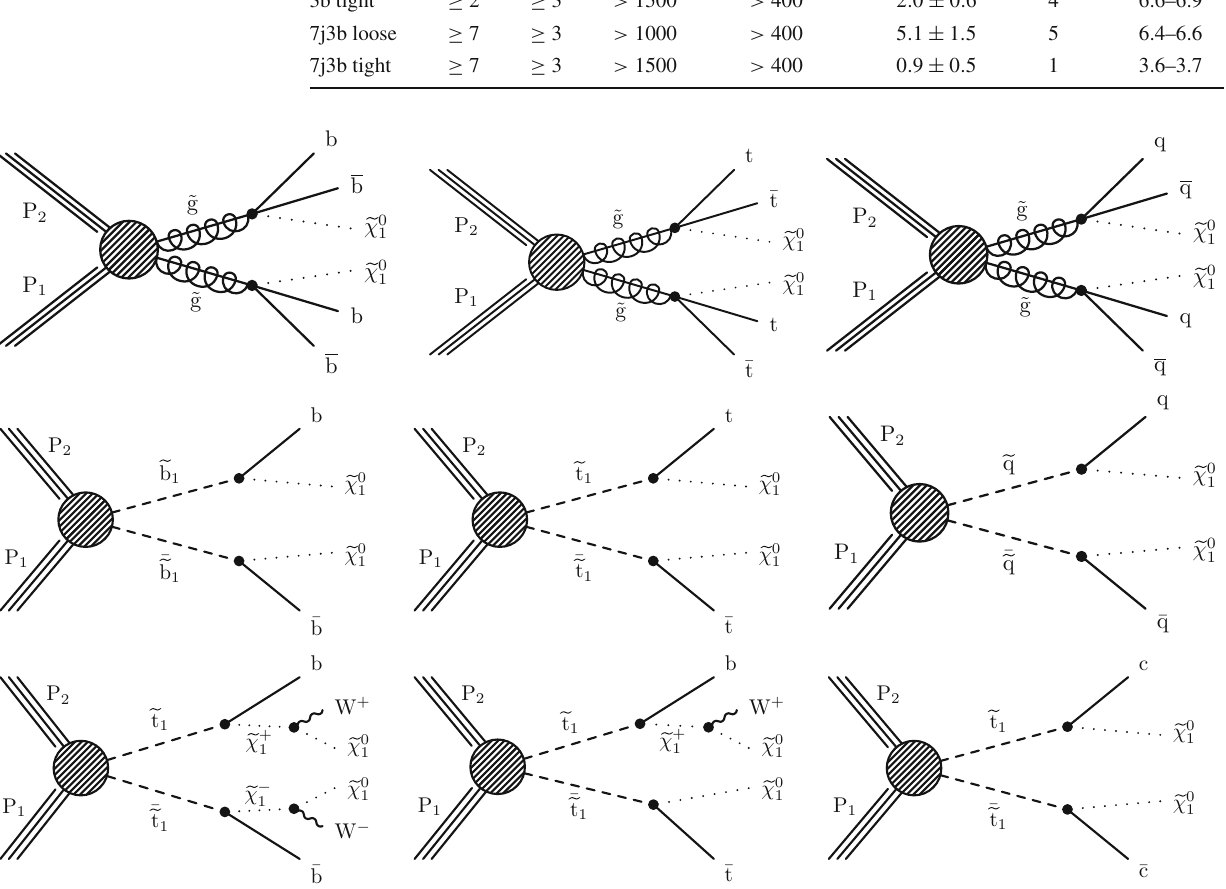
Fig. 5 (Upper) Diagrams for the three scenarios of gluino-mediated bottom squark, top squark and light flavor squark production consid- ered. (Middle) Diagrams for the direct production of bottom, top and light-flavorsquarkpairs.(Lower)Diagramsforthreealternatescenarios